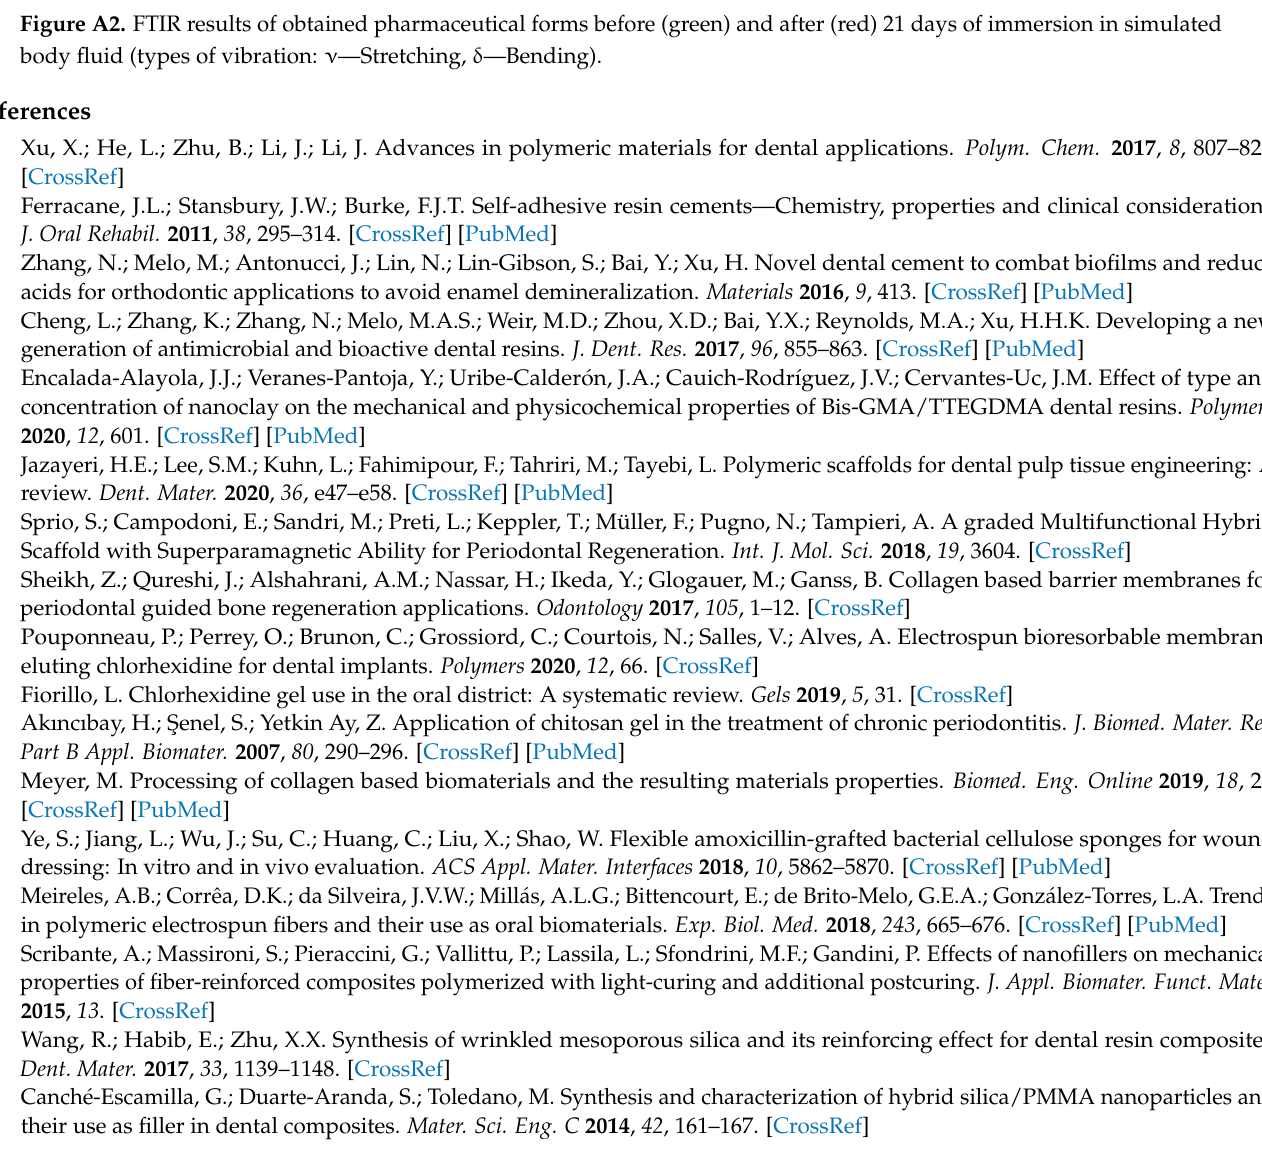
Figure A2. FTIR results of obtained pharmaceutical forms before (green) and after (red) 21 days of immersion in simulated body fluid (types of vibration: ν —Stretching, δ